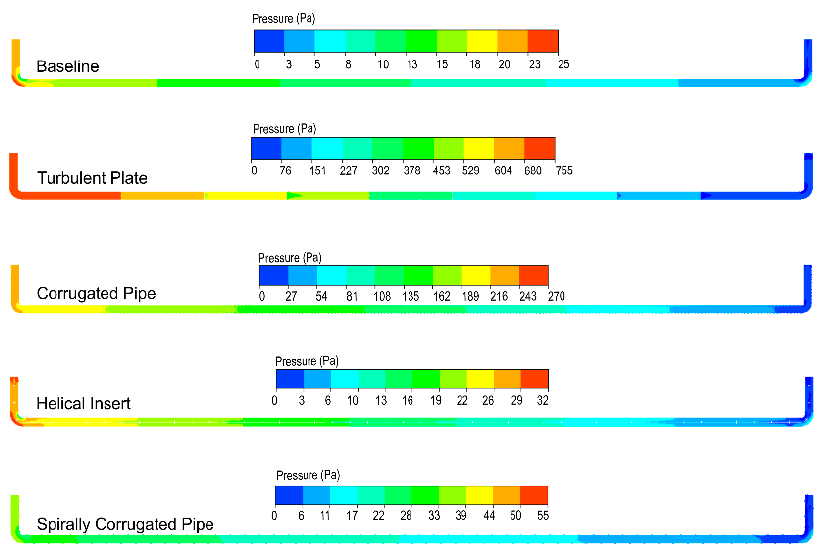
Figure 14. Temperature profile in the middle plane for five investigated pipes.